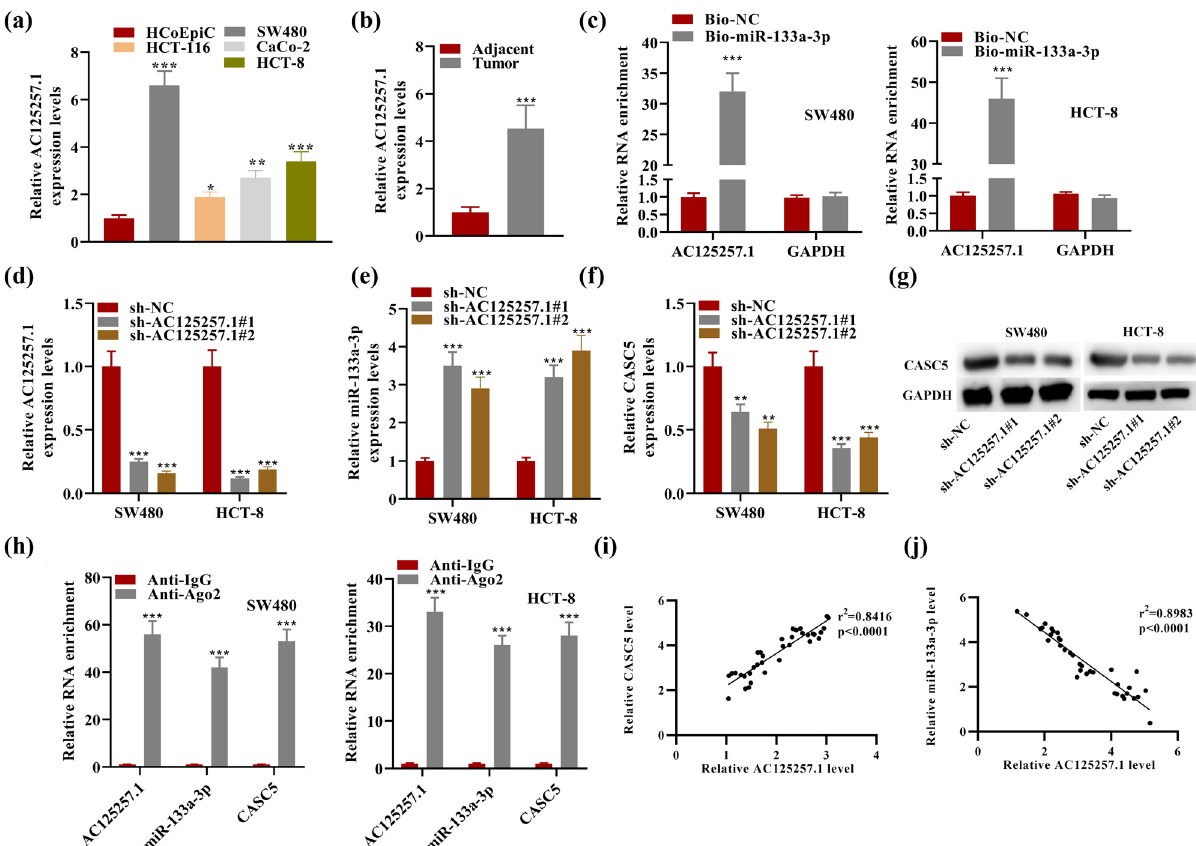
Figure 4: ( a ) Relative AC125257.1 expression in HCoEpiC and four other CRC cell lines. ( b ) Relative AC125257.1 expression in adjacent and tumor. ( c ) RNA pull - down results of AC125257.1 using bio - miR - 133a - 3p or bio - NC. ( d ) Relative AC125257.1 expression in SW480 and HCT - 8 cell lines transfected with sh - NC/sh - AC125257.1. ( e ) Relative miR - 133a - 3p expression in SW480 and HCT - 8 cell lines transfected with sh - NC/sh - AC125257.1. ( f ) Relative CASC5 expression in SW480 and HCT - 8 cell lines transfected with sh - NC/sh - AC125257.1. ( g ) Western blot results of CASC5 and GAPDH in SW480 and HCT - 8 cell lines transfected with sh - NC/sh - AC125257.1. ( h ) AC125257.1 and miR - 133a - 3p levels detected by RIP. ( i ) Pearson correlation analysis was conducted to examine the expression correlation between CASC5 and AC125257.1. ( j ) The expression correlation between AC125257.1 and miR - 133a - 3p in CRC patient tissues. * P < 0.05, ** P < 0.01, *** P <